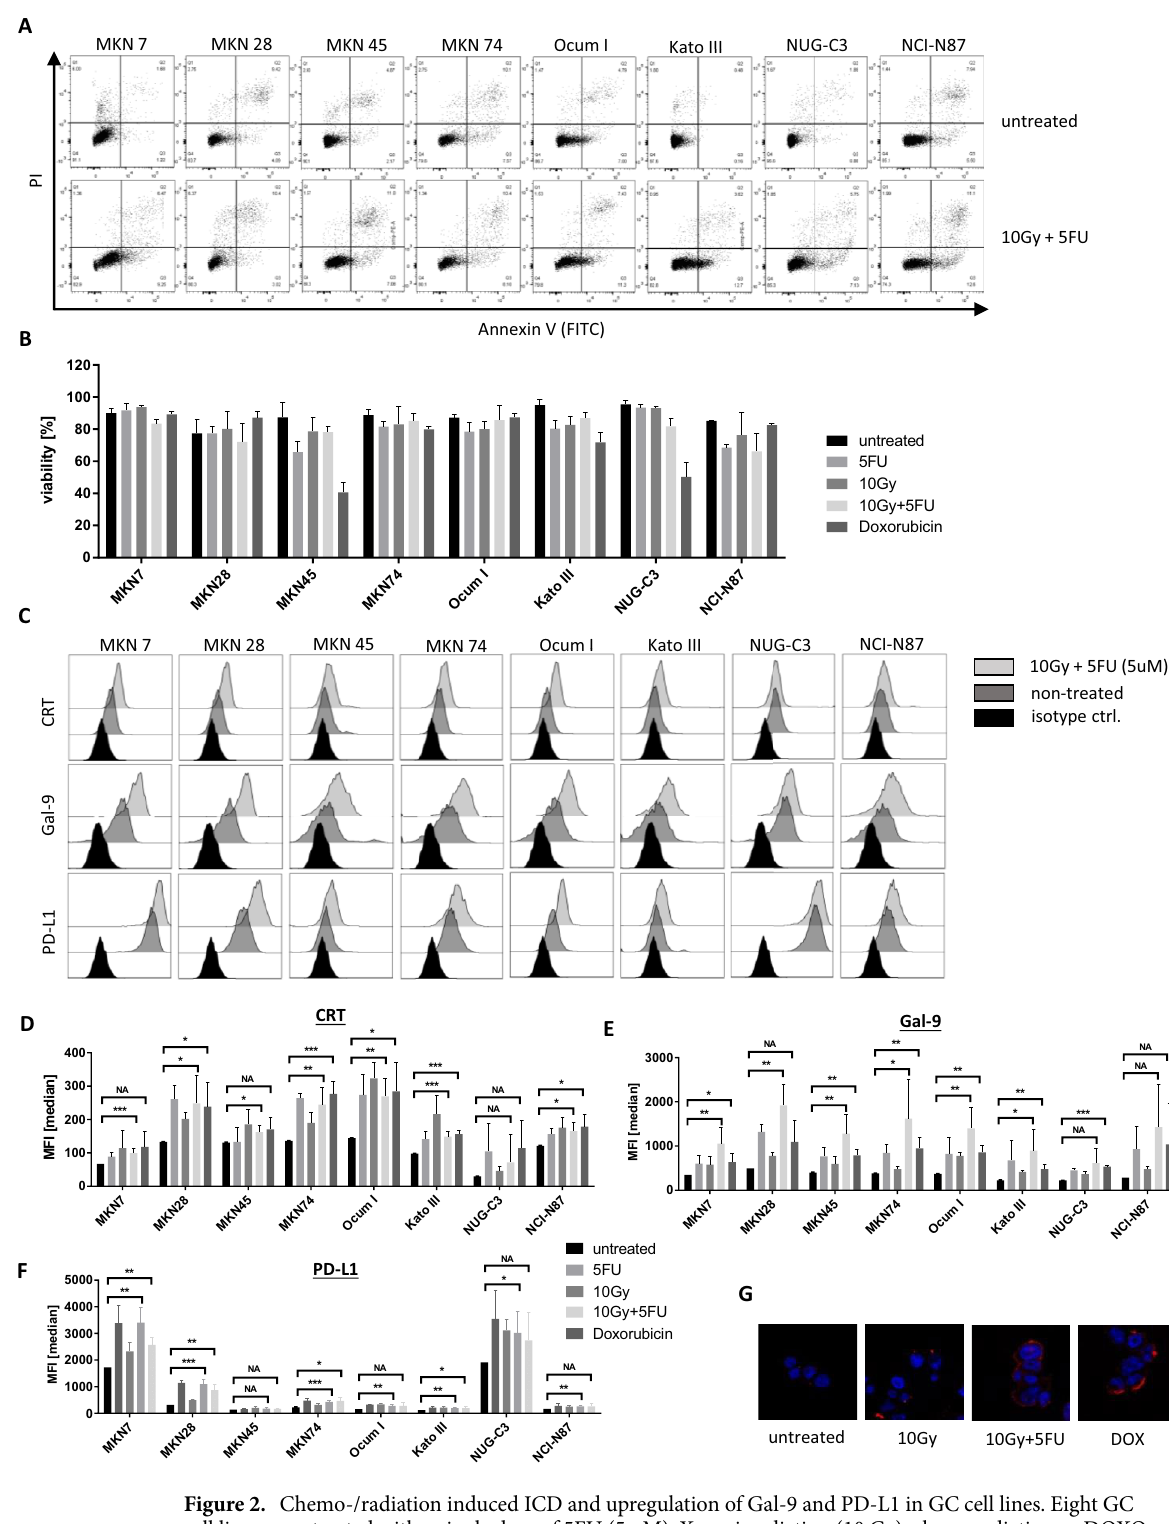
Figure 2. Chemo-/radiation induced ICD and upregulation of Gal-9 and PD-L1 in GC cell lines. Eight GC cell lines were treated with a single dose of 5FU (5 μM), X-ray irradiation (10 Gy), chemoradiation or DOXO (0.5 μM) and analyzed 48 h after single dose treatment. ( A ) Flow cytometry data displaying level of apoptosis in each cell line for untreated and chemoradiation treated cells, ( B ) bar graph of viability of GC cell lines for each condition, ( C ) representative flow cytometry data for protein expression of CRT, Gal-9 and PD-L1 in each cell line, either untreated or after chemoradiation, ( D – F ) bar graphs displaying MFI for CRT, Gal-9 and PD-L1, respectively, ( G ) immunofluorescent imaging of CRT expression in MKN74 cells. Bar graphs display the mean and SEM of at least 3 biological replicates. *P < 0.05, **P < 0.01, ***P < 0.001, NA not